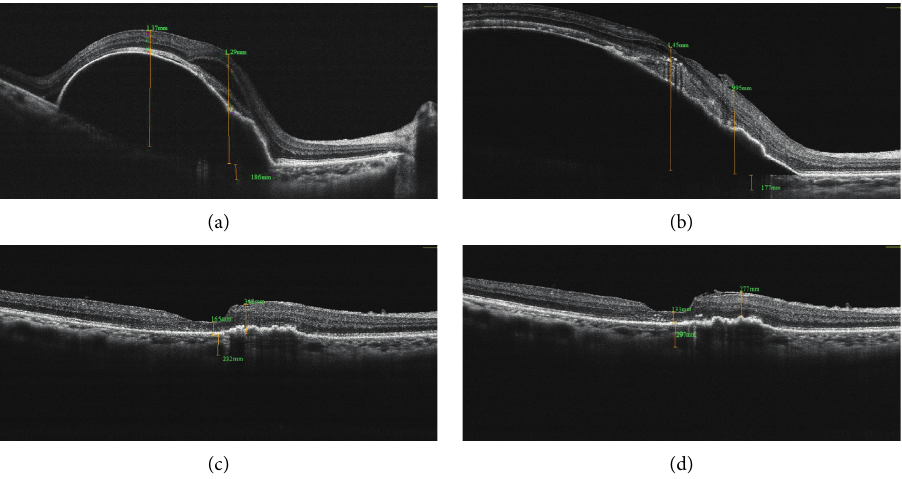
Figure 4: A representative case showed remarkable PED reduction after switch from conbercept to ranibizumab. (a) OCTat baseline visit showed large PED with SRF. (b) 1 month after the third IVC, PED did not improve but progressed; SRF became hyperreflective on OCT. (c) Patient was then switched to IVR. One month after the first IVR, PED dramatically decreased with SRF partially resolved. (d) After 3 monthly injections of ranibizumab, no SRF was present on OCTand only a very shallow PED was left. The total follow-up was eight months.